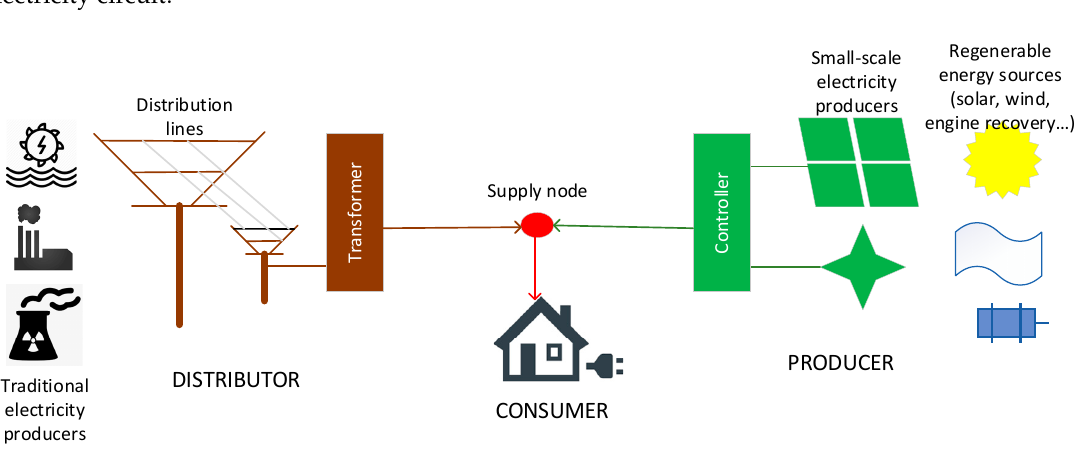
Figure 1. Consumer–producer–distributor structure.